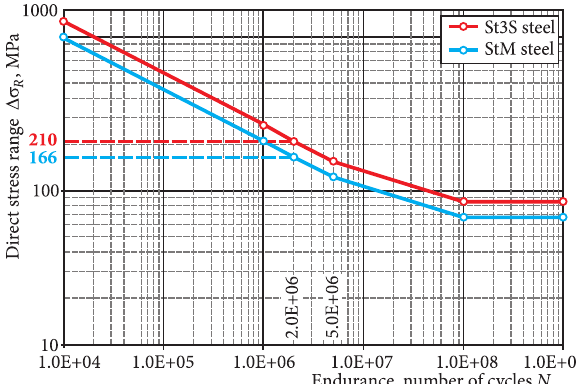
Fig. 6. Fatigue strength curves for the railway bridge steel, StM, and the reference structural steel,